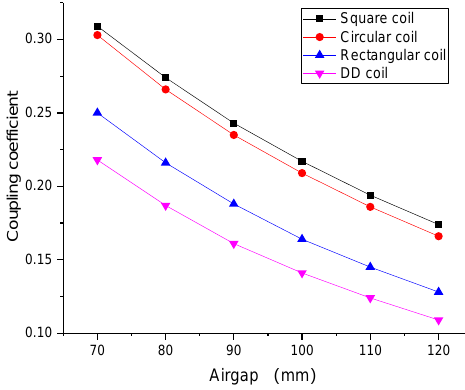
Figure 5. Coupling coefficient versus the air-gap distance.